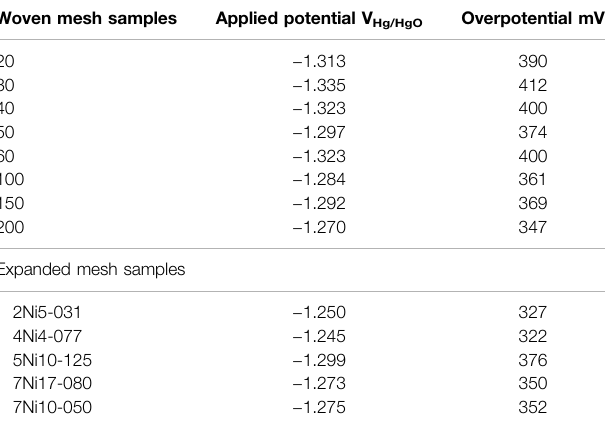
TABLE 3 | The applied potential and overpotential at 150 mA current of complex- structured material. Woven mesh